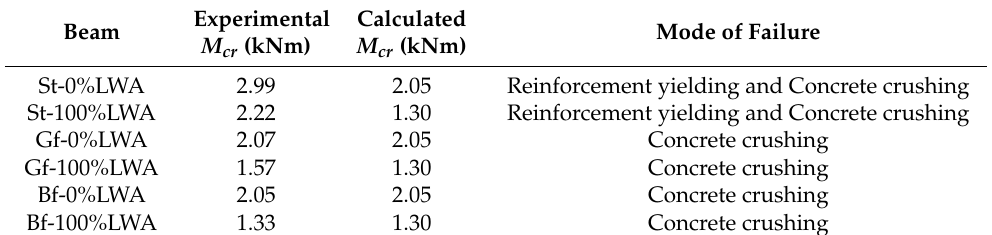
Table 9. First moment of crack calculated by ACI equation and experimental values.